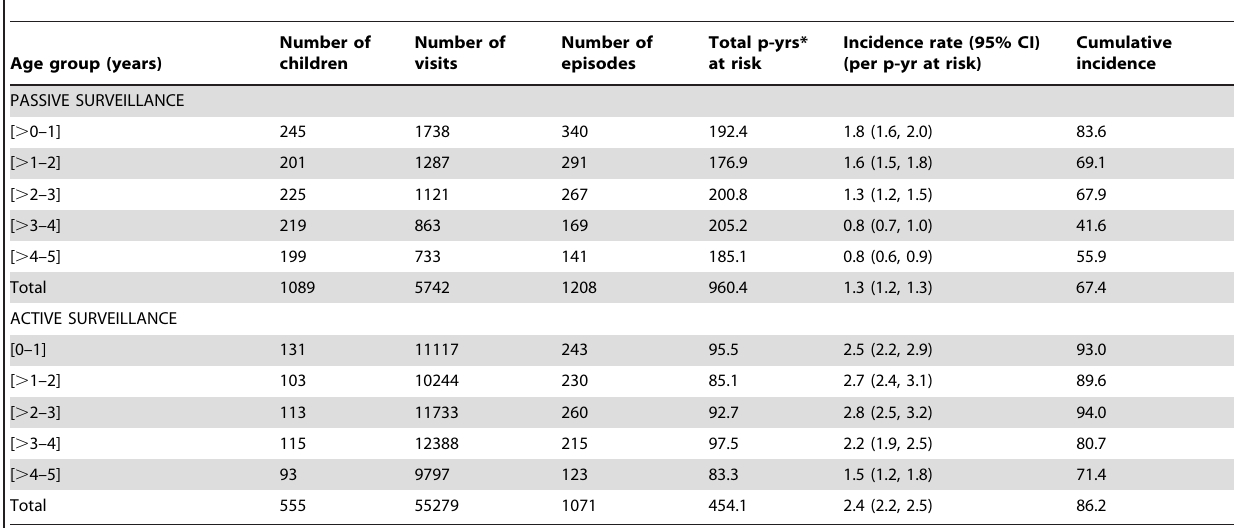
Table 3. Age-specific incidence of clinical malaria episodes parasitemia threshold for malaria case definition: . 0 parasites/ m l during high and low